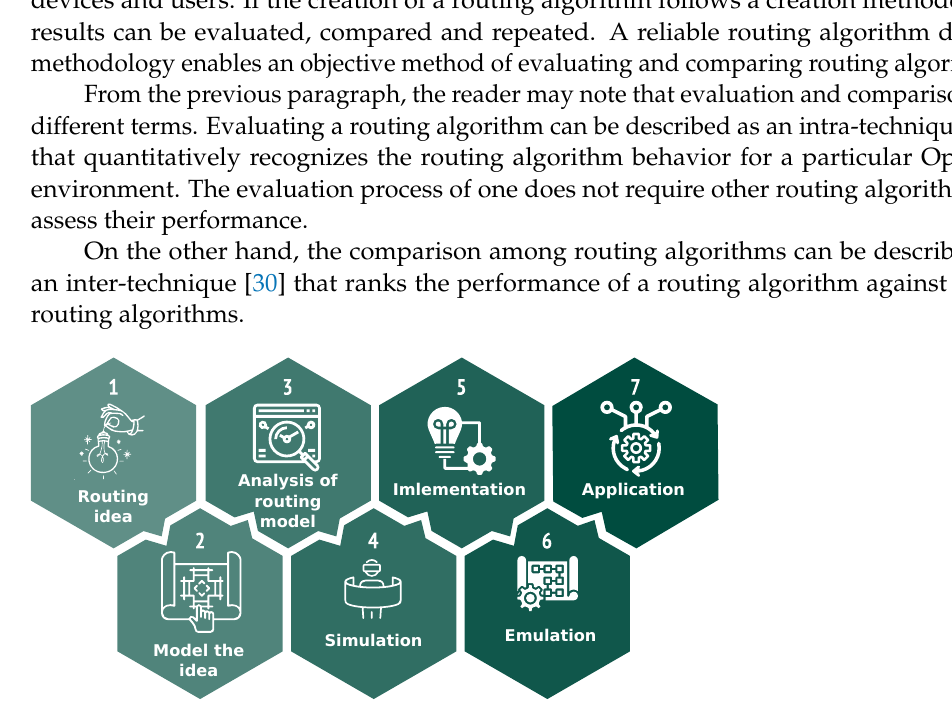
Figure 1. Seven-stage methodology for routing algorithm creation